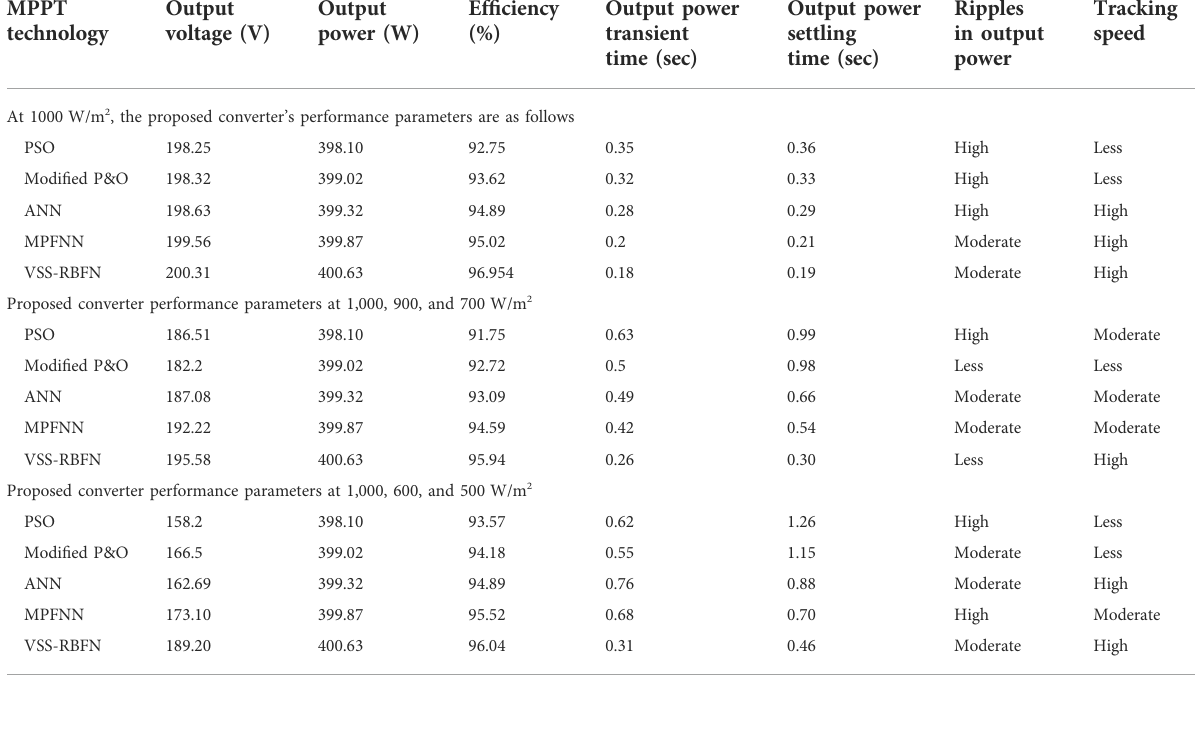
TABLE 1 Based on MATLAB/Simulink results of the proposed converter ’ s performance while using various MPPT techniques. MPPT